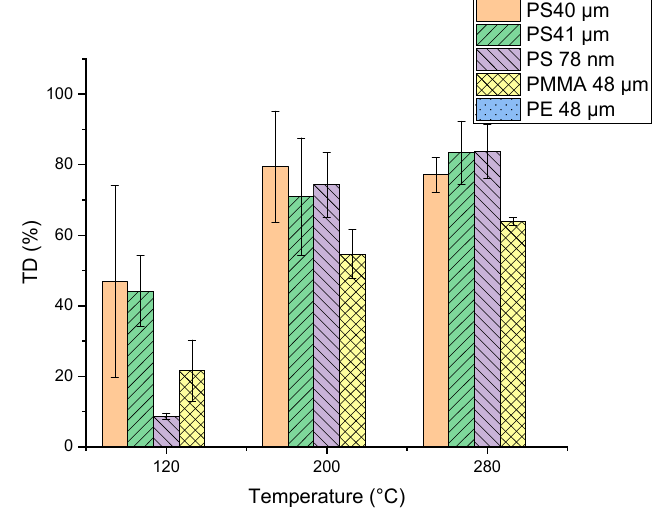
Figure 5. Percentage of the characteristic pyrolysis products of the polymers (Table 1) of the single polymers (polymethyl methacrylate (PMMA), polyethylene (PE) and polystyrene (PS)) already visible in the TD Chromatogram calculated from the peak areas. The remaining percentage of the characteristic pyrolysis products is visible in the